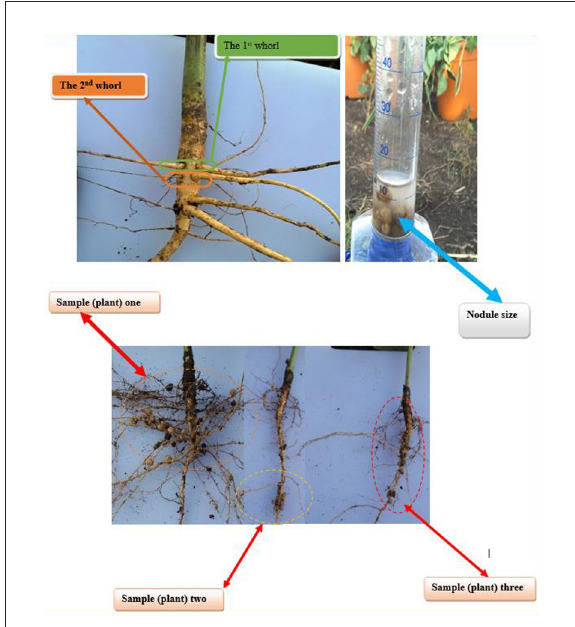
FIGURE2 Nodule distribution, number of whorls, angle of whorls, the position of whorls and nodule size.